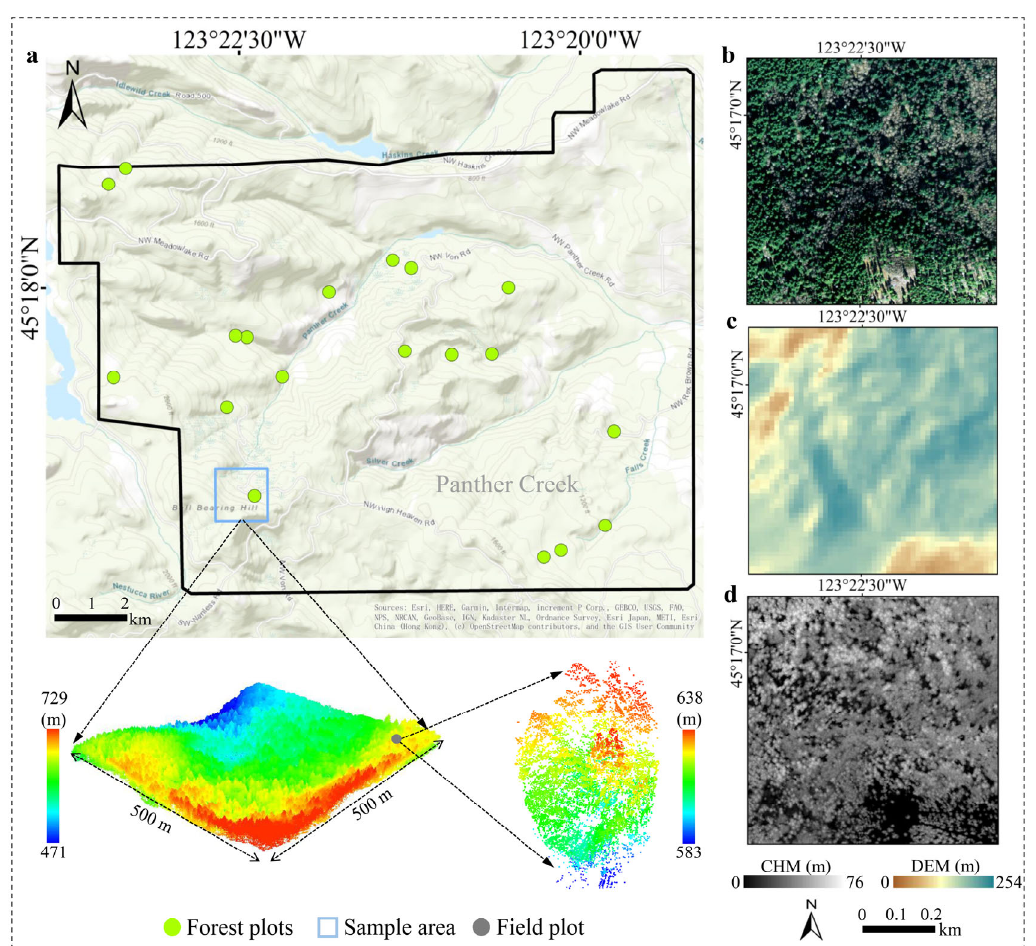
Figure 1. ( a ) The location of the study area was in Panther Creek, Oregon in northwest USA; ( a ) also had sample area’s point clouds, ( b ) was the hyperspectral image, ( c ) was the digital elevation model (DEM), and ( d ) was the canopy height model (CHM) of the sample